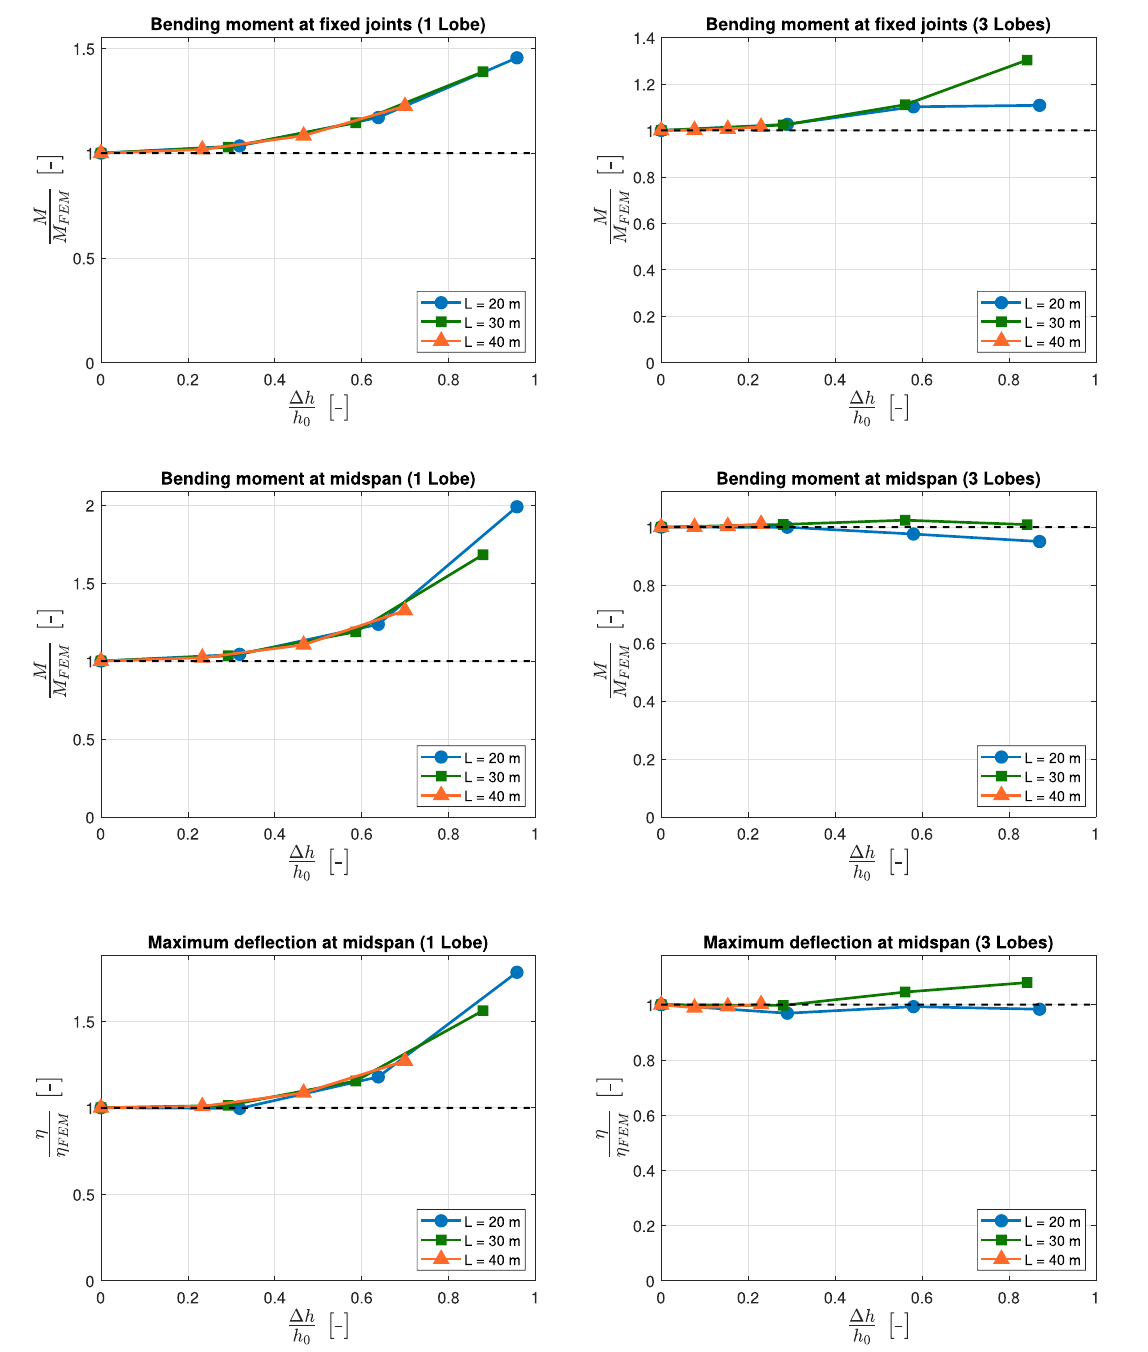
Fig. 8 Bending moments at fixed joint, midspan and maximum deflection comparison diagrams for the optimal results obtained by the GA and the dog-bone Matlab models respect to the FEM Midas actual models results for three hypothetical span length L = 20,30,40